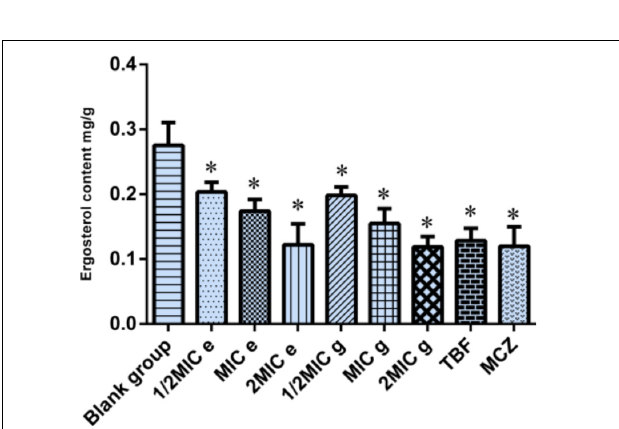
FIGURE 3 | Effect of compounds e and g on the ergosterol synthesis of Microsporum canis (blank group, ergosterol; MIC e -value, 20 µ g/mL; MIC g -value, 10 µ g/mL; MCZ, miconazole nitrate; TBF, terbinafine hydrochloride; ∗ comparison with blank group, P < 0.05).